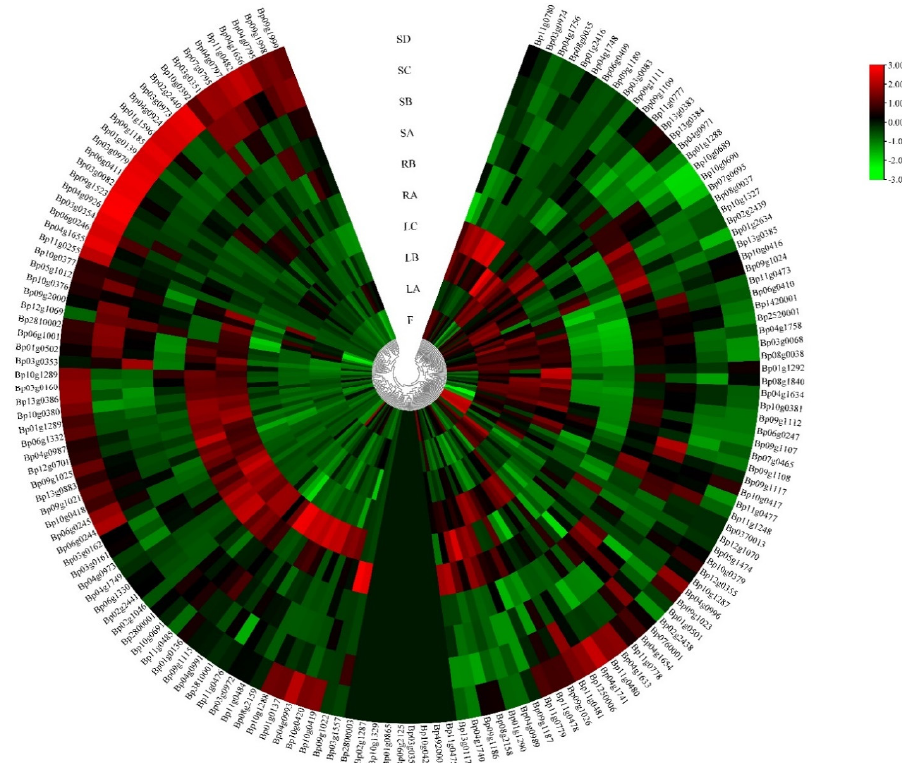
Figure 3. Expression profiles of the BpUGT genes with hierarchical clustering in different tissues. A cluster dendrogram is shown in the middle. The color scale at the right of the dendrogram represents log2-based expression values transformed from fragments per kilobase of exon per million reads mapped (FPKM) values. Red and green colors indicate higher levels and lower levels, respectively. SD: phloem of mature stem; SC: phloem of proximal stem; SB: immature stem; SA: shoot apex; RB: phloem of root; RA: root tip; LC: mature leaf; LB: developing leaf; LA: young leaf; F: